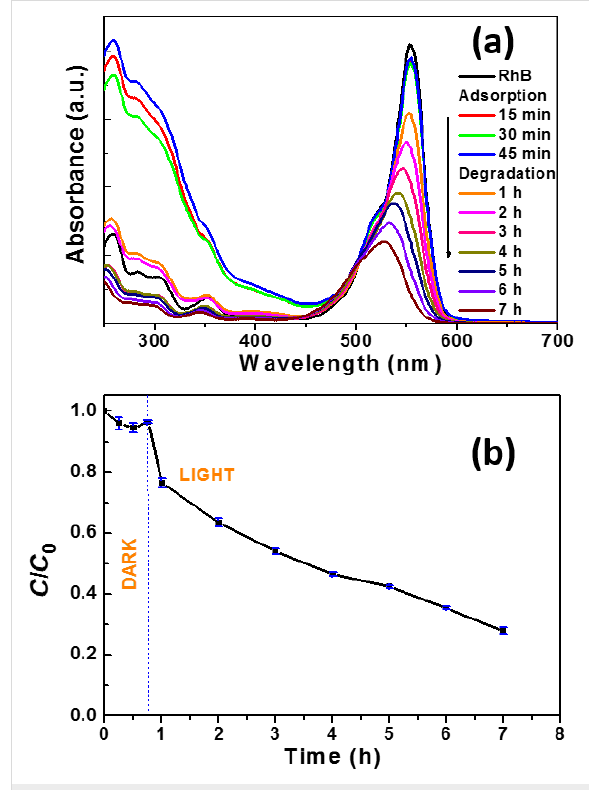
Figure 9: (a) UV–visible spectral evolution of rhodamine B as a func- tion of irradiation time using the CdSe (2 wt %)/TiO 2 catalyst under visible light irradiation (light intensity: 10 mW/cm 2 ) and (b) evolution of C / C 0 vs irradiation